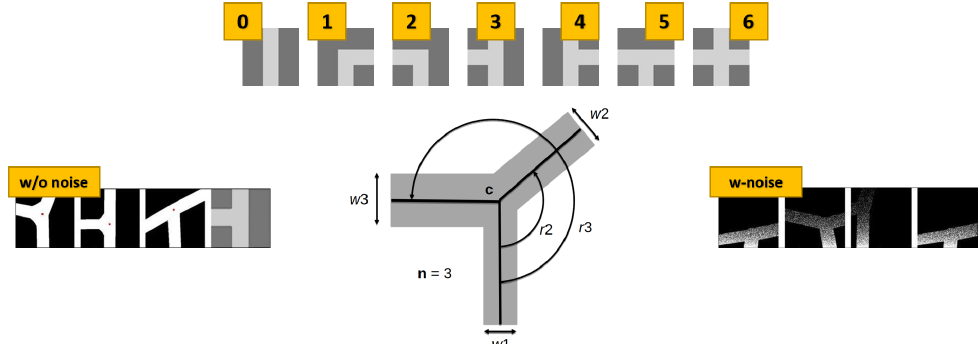
Figure 8. On the top of the image, the seven so-called canonical intersection classes along with the model used to generate the training dataset. In the leftmost part of the figure, identified with the label “w/o noise” , a triplet consisting of two samples of the canonical type-three (for simplicity also shown in the last box of the row) and a different one, e.g., type-five . Before passing these images to the teacher network during the training phase, random noise is added to each image by increasing extent along the vertical direction. The effect is shown in the rightmost part of the figure identified with the label “w-noise” .